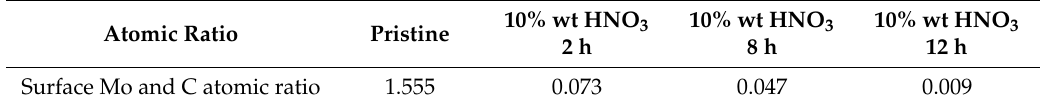
Table 1. Surface Mo and C atomic ratio of different HNO 3 etching duration samples.